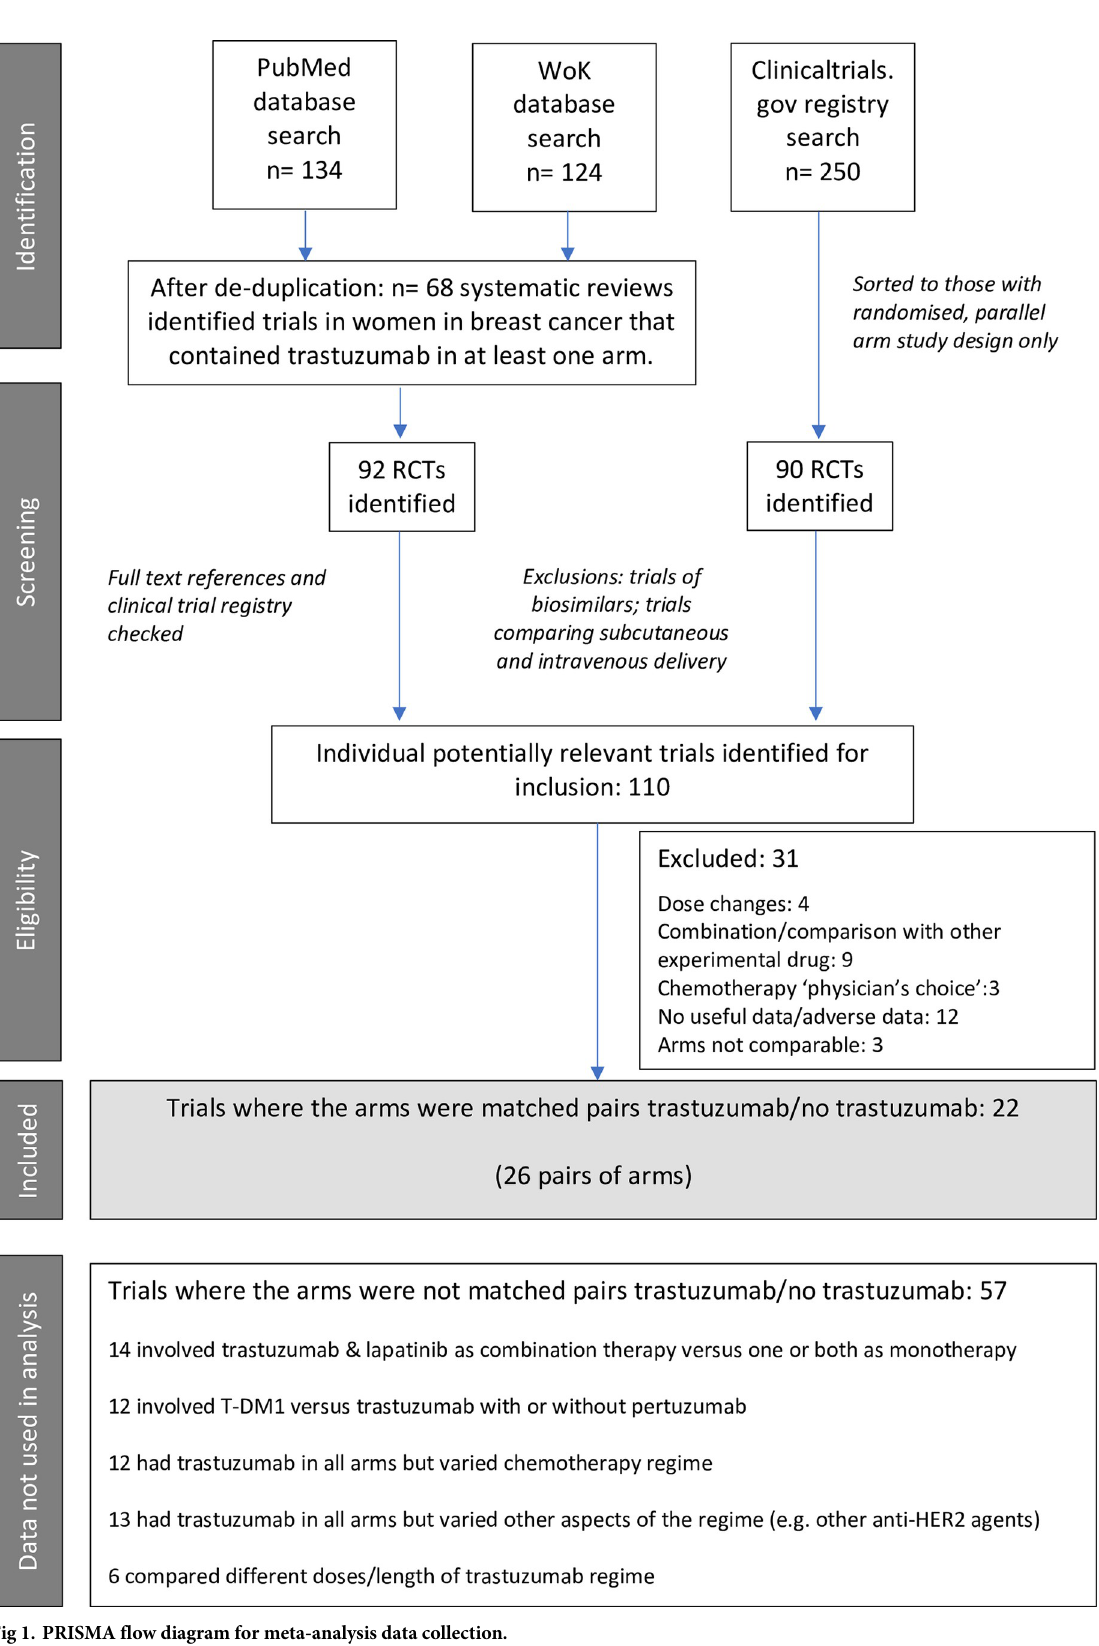
Fig 1. PRISMA flow diagram for meta-analysis data collection. https://doi.org/10.1371/journal.pone.0275321.g001 PLOS ONE | https://doi.org/10.1371/journal.pone.0275321 December1,